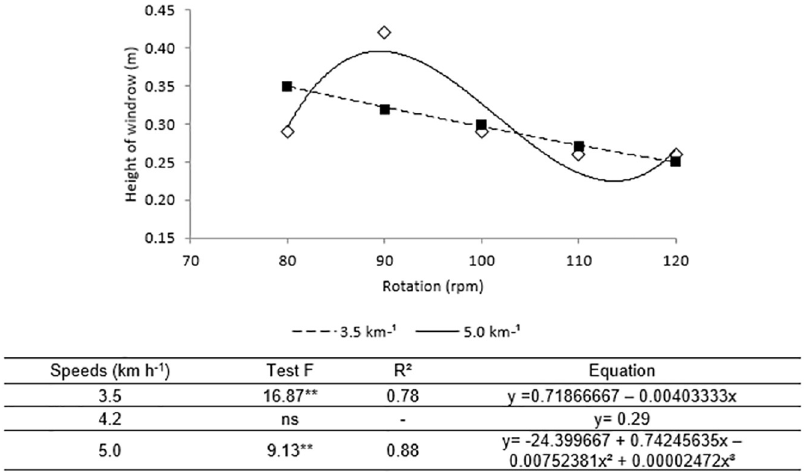
Fig 5. Windrow height versus rotation of the vibrating conveyor belt for the velocities 3.5 e 5.0 km -1 . The equation of adjustment of each interaction is shown below Fig 5, when this was significative by the F test ( �� p < 0.05). The speed 4.2 km h -1 did not obtain significant adjustment